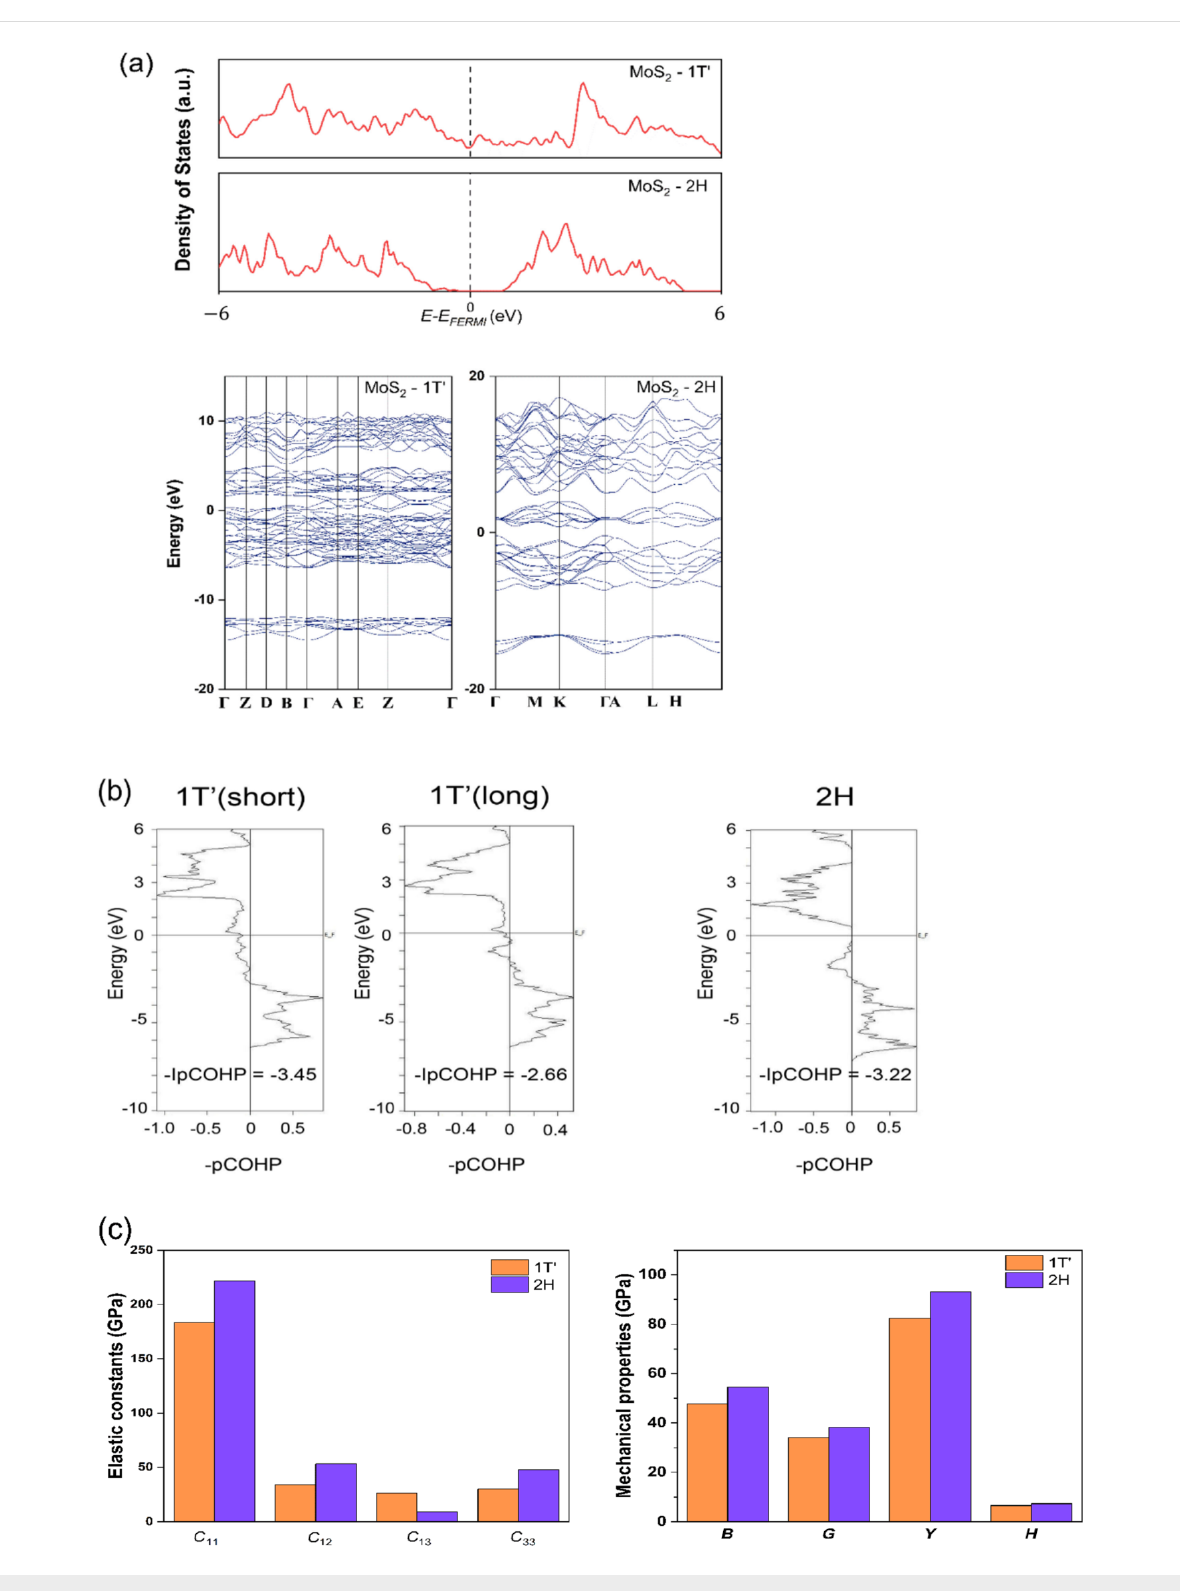
Figure 5: (a) Total and partial DOS and band structure of MoS 2 in its 1T ′ and 2H polytypes. (b) Calculated -pCOHP and -IpCOHP of 1T ′ long and short Mo-S bonds in 1T ′ MoS 2 as indicated in Figure 1 and Mo-S bond in 2H MoS 2 . (c) Elastic constants and mechanical properties including B , G , Y and H of MoS 2 in its 1T ′ and 2H